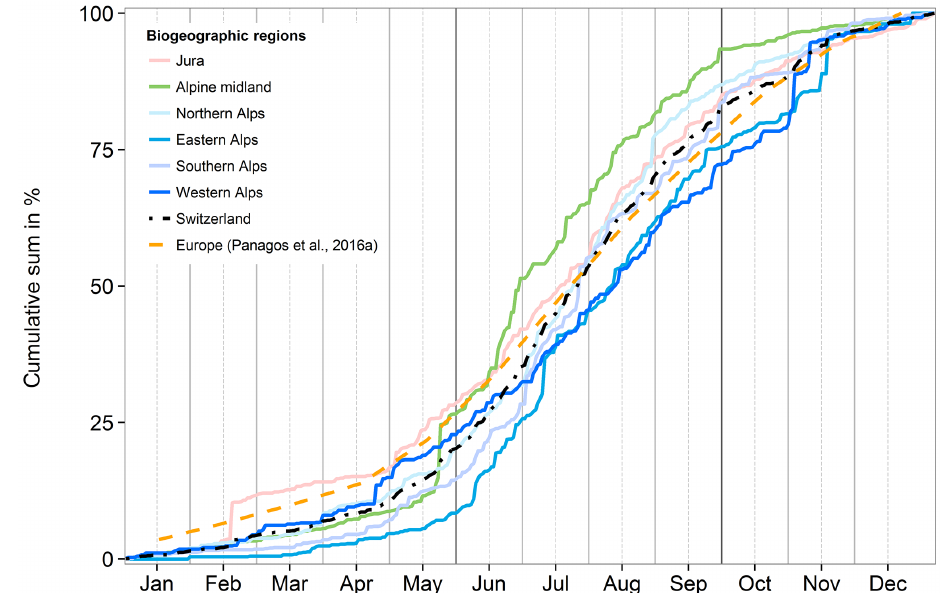
Figure 6. Cumulative daily rainfall erosivity proportion for Swiss biogeographic units, Switzerland and monthly rainfall erosivity for Europe (linear smoothed, European data from Panagos et al.,